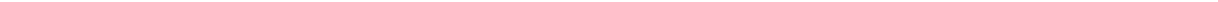
Fig. 1 Intravascular traf fi cking of CX 3 CR1+ YS pre-macrophages. a , b Schematic graphs of the mouse model ( a ) and the intravital imaging setup in Cx 3 cr1 GFP/ + mice ( b ). c E16.5 Cx 3 cr1 GFP/ + embryo with surrounding YS and its dense vascular network. d YS tissue with CX 3 CR1+ pre-macrophages at indicated time points. Pictures show a representative microscopic fi eld of 400 × 400 µ m. e Corresponding quanti fi cation of CX 3 CR1+ cells per microscopic fi eld of 400 × 400 µ m; *** p < 0.001 (two-tailed Mann – Whitney test); graph shows median with interquartile range ( ± IQR, error bars). f In vivo YS staining for the endothelial marker CD31 (red) in Cx 3 cr1 GFP/ + (green) embryos at E10.5. g , h , j Images extracted from E10.5 video sequences of CX 3 CR1+ YS tissue show a cell entering the vasculature ( g , from Supplementary Movie 1) as well as intravascular non-adhering ( h , from Supplementary Movie 3) and rolling ( j ) cells. CX 3 CR1+ cells in focus are indicated by arrowheads; direction of fl ow from bottom to top ( g ), left to right ( h ), left to right ( j ). i Quanti fi cation of intravascular CX 3 CR1+ cells in the YS in an average-sized vessel; median ± IQR. k Velocity of intravascular non-adhering ( n = 50) and rolling ( n = 5) CX 3 CR1+ cells in the YS at E10.5; median ± IQR. Scale bars are 1 mm ( c ), 100 µ m ( d , f , g , h , j